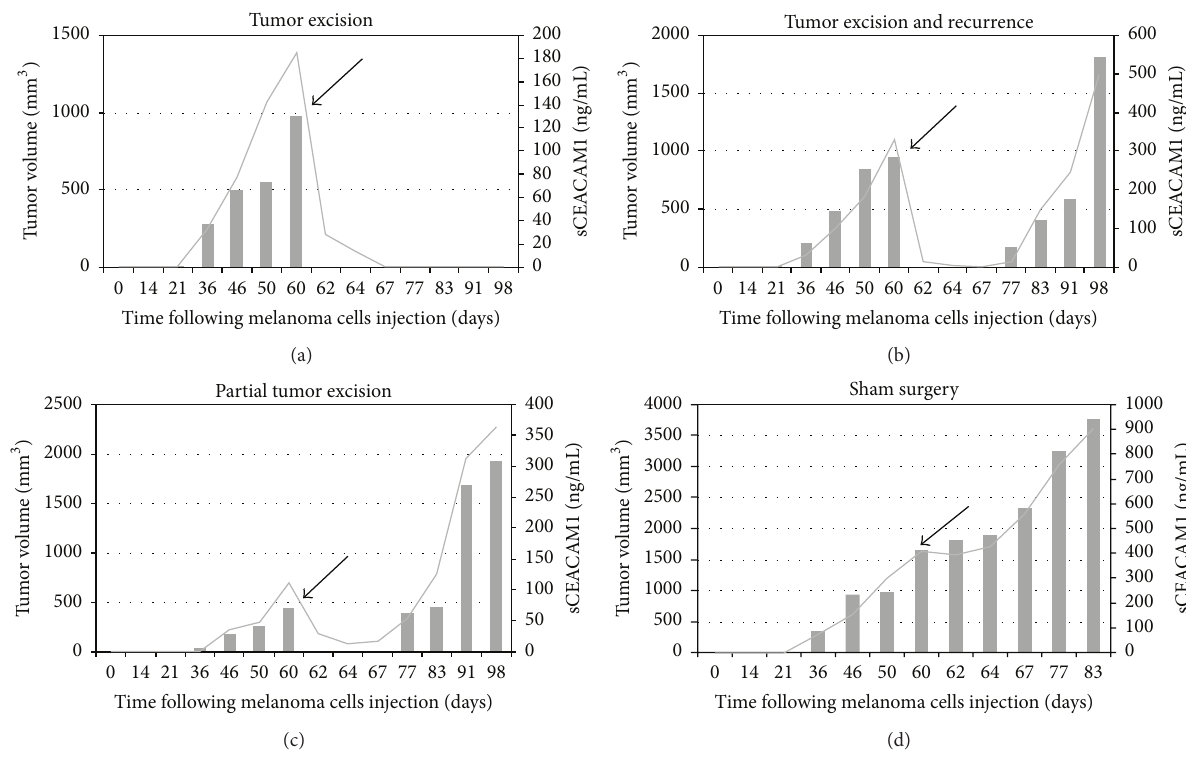
Figure 2: sCEACAM1 sensitively reflects tumor excision and recurrence in mice. 20 SCID-NOD mice were subjected to subcutaneous injection of 009mel cells. When tumors reached ∼ 500 mm 3 , they were excised from half of the mice in a complete ((a), 𝑛 = 3 ) or partial ((b)-(c), 𝑛 = 7 ) manner while the other mice underwent sham surgery ((d), 𝑛 = 10 ). In some of the mice recurrence of tumor occurred ((c), 𝑛 = 4 ). sCEACAM1 levels (depicted by a solid line) as well as tumors volumes (gray bars) were periodically measured and plotted against time. The arrow denotes the excision time point. The experiment was repeated two independent times. Shown are results from one representative mouse from each group.